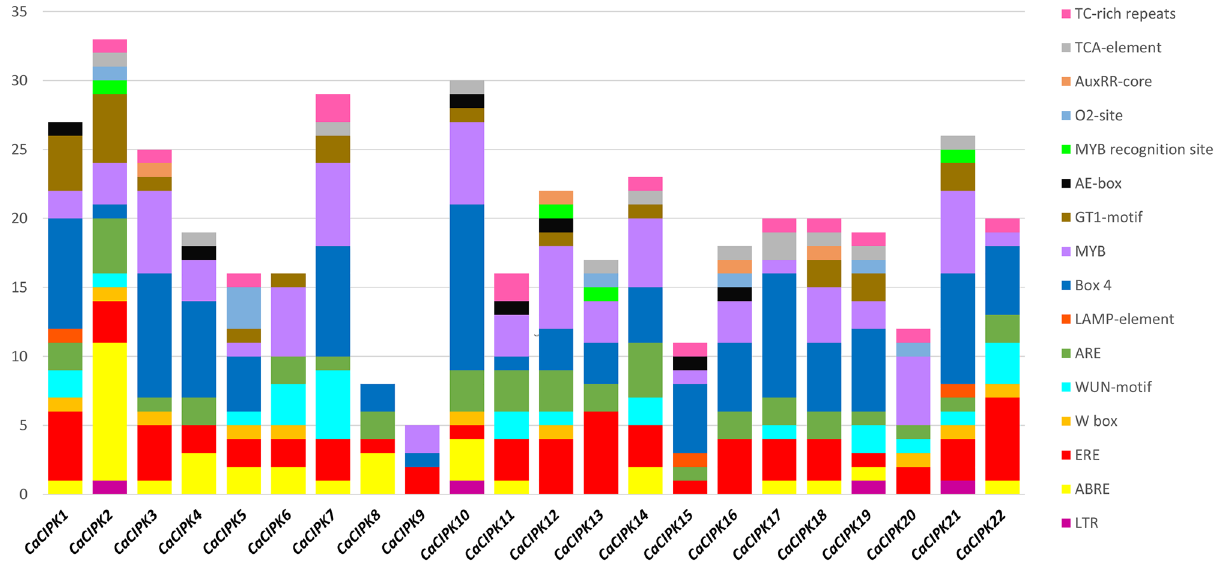
Figure 4. Promoter analysis of chickpea CIPK genes. Different cis -regulatory elements in the 2 kb upstream region of 22 CaCIPK genes are illustrated by different colours in the bar chart. The X-axis represents the name of genes and Y-axis represents the number of cis -elements in each promoter. The names of cis -regulatory elements are mentioned on the